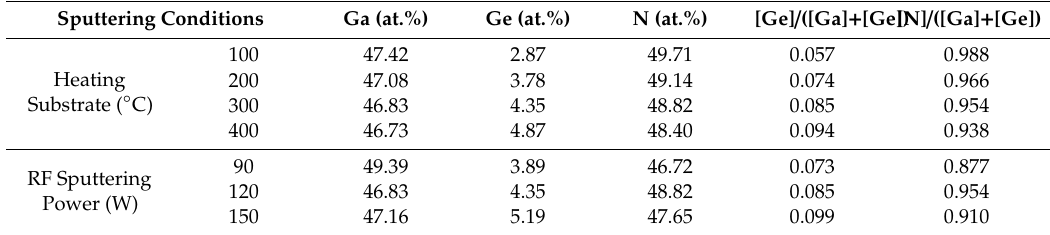
Table 1. EDS composition of Ge 0.07 GaN films under di ff erent deposition conditions.